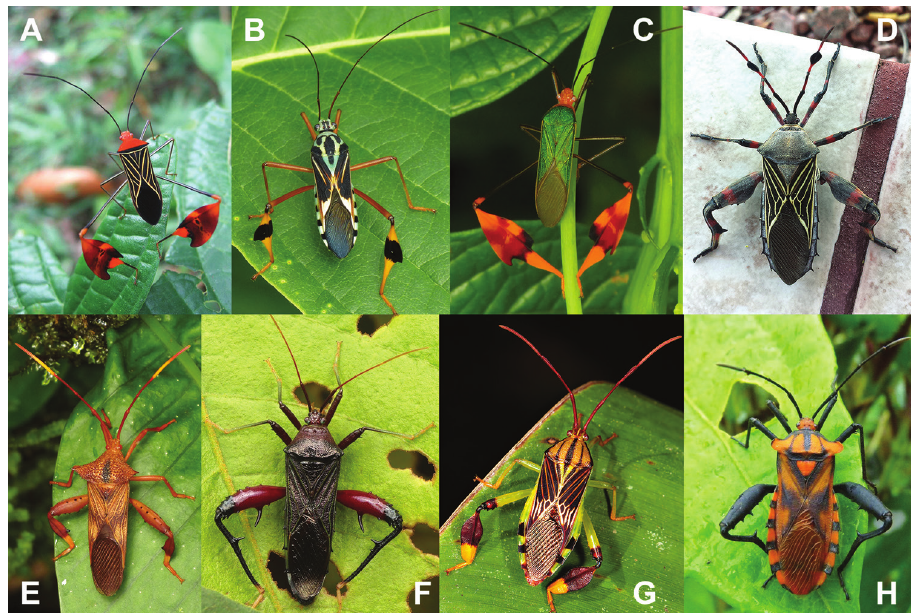
Figure 1. Examples of ornamentation in live extant coreids. Images A–C, G with expansions on the hind tibiae. Images D–H with hind leg spination D with expansions to the third antennal segment. Im- ages B, C, E–H photographed by Andreas Kay (Ecuador), other images with appropriate citations given individually A Anisocelis flavolineata from Veraguas Province, Panama, photographed by Dirk van der Made (Netherlands) B Unidentified Coreidae from Ecuador C Anisoscelis foliacea from Ecuador D Thasus sp. from Santa Cruz County, Arizona, USA, photographed by Alan Schmierer (USA) E Unidentified Coreidae from Ecuador F Unidentified Coreidae from Ecuador G Melucha quinquelineata from Ecuador H Piezogaster cf. humeralis from